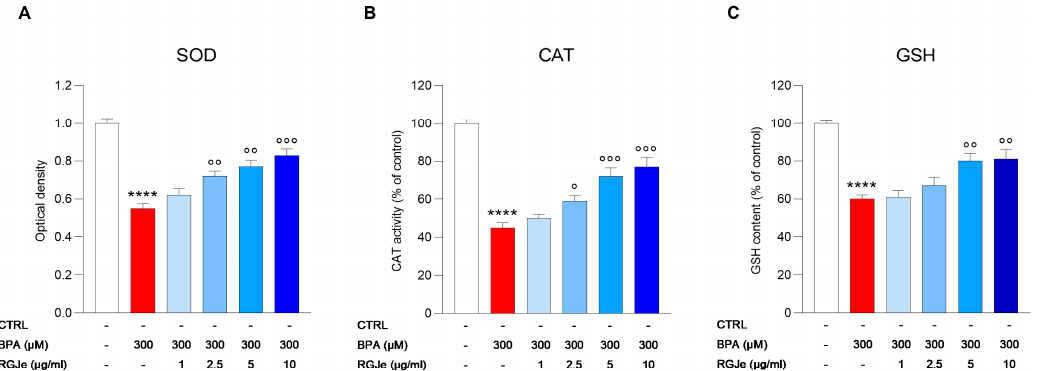
Figure 4. Effect of the pre-treatment with RGJe on antioxidant defense systems reduced by BPA in HUVECs. The activity of SOD ( A ) and CAT ( B ), as well as GSH levels ( C ) are reported. Data are expressed as the mean ± SEM of three separate experiments performed in triplicate (n = 9). **** p < 0.0001 vs. CTRL; ° p < 0.05, °° p < 0.01, °°° p < 0.001 vs. BPA 300 µM.